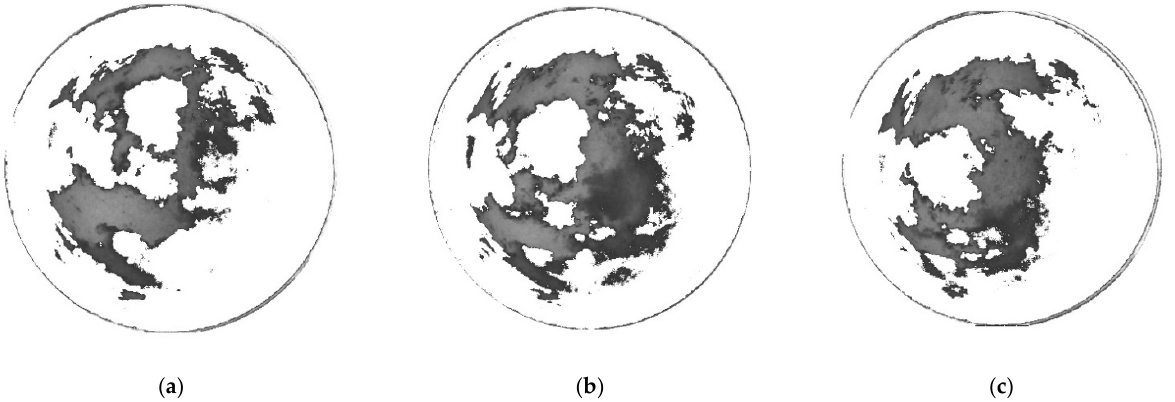
Figure 1. From ( a – c ); hemispheric sky imager (HSI) images showing examples of cloud shape changes within a 3-min interval. The gray area corresponds to sky pixels and white area corresponds to clouds. All cloud identification was derived from the original HSI pictures.